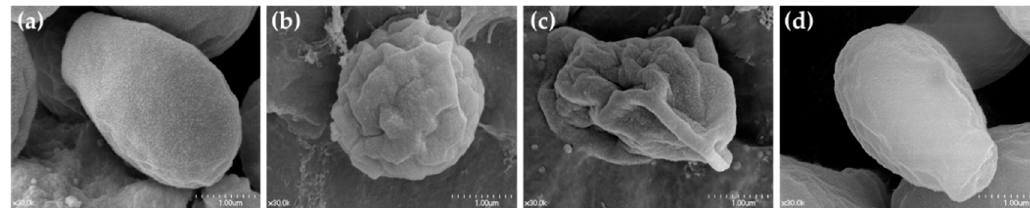
Figure 3. Scanning electron microscopic view of Candida albicans cell membranes disrupted by endodontic irrigants / medications (30,000 × ). ( a ) Saline (control), ( b ) chlorhexidine gel, ( c ) synthetic HBD3-C15, and ( d ) calcium hydroxide.